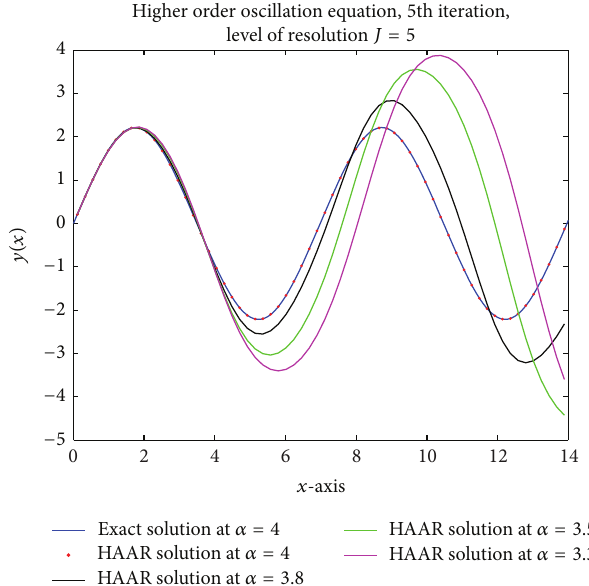
Figure 5: Higher order oscillation equation. Exact solution at 𝛼 = 4 and solution by Haar wavelet-quasilinearization technique at 𝐽 = 5 and different values of 𝛼